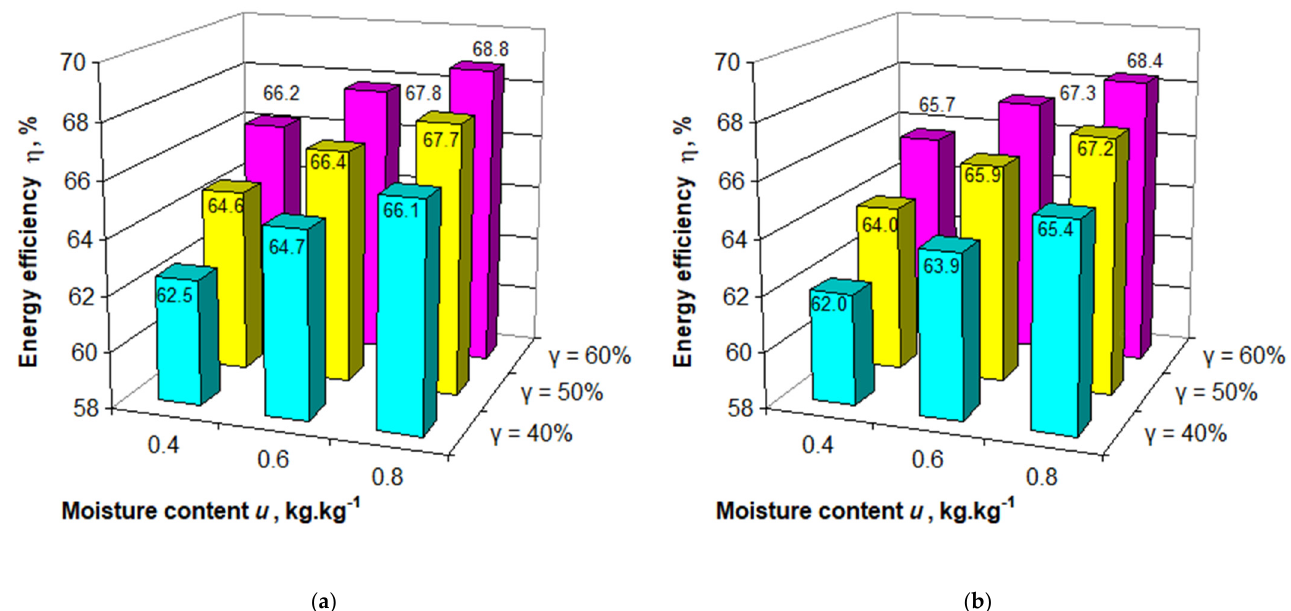
Figure 9. Change in η of regimes for steaming at t m1 = 130 °C of beech prisms with t w0 = 0 °C, d × b = 0.3 × 0.3 m ( a ), and d × b = 0.5 × 0.5 m ( b ) in an autoclave with D = 2.4 m and L = 9 m, depending on u and γ .